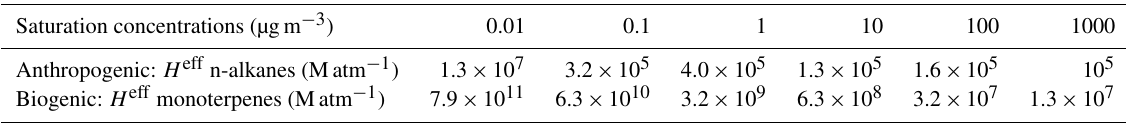
Table 2. Henry’s law constants used in this study based on values reported in Hodzic et al. (2014). H eff of the oxidation products of n-alkanes is used for oxidation products of all anthropogenic precursors, whereas H eff of the oxidation products of monoterpenes is used for those of biogenics. For products of IVOCs used in Table 1, we use H eff = 10 3 Matm − 1 .